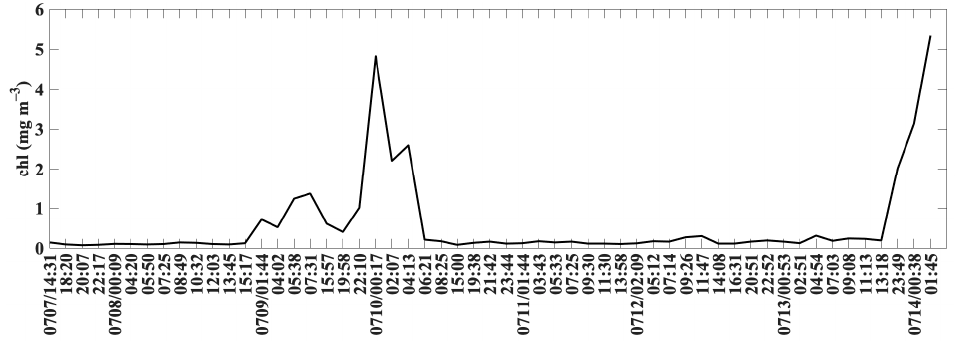
Figure 10. Chl-a data from the Kiyomoto_Yoko experiment (7–14 July 2003).